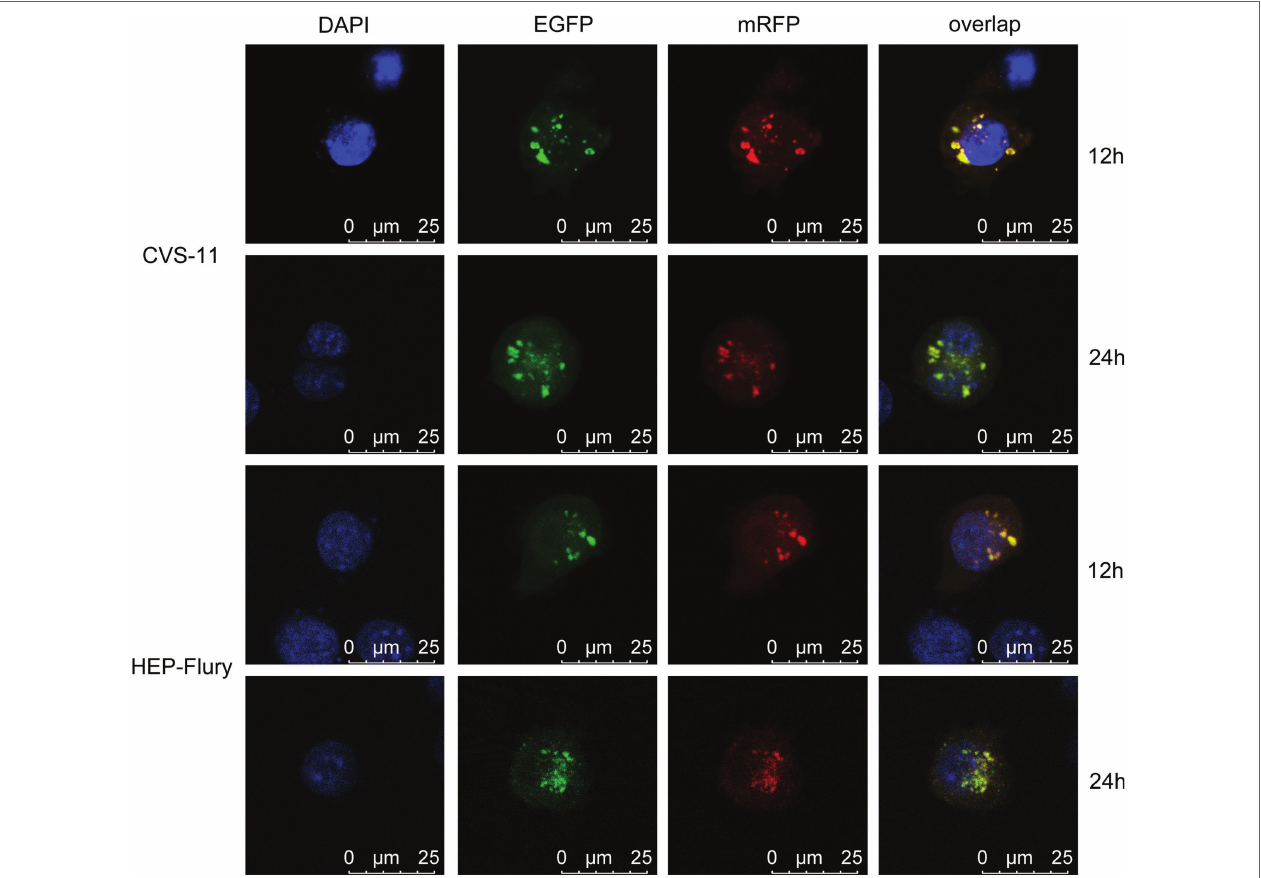
FIGURE 4 | To monitor the fusion of autophagosomes with lysosomes, BV2 cells were transfected with mRFP-EGFP-LC3 plasmids and then, respectively, infected with CVS-11 or HEP-Flury at an MOI of 3. The fluorescent dots in BV2 cells were analyzed directly at 12 and 24 hpi by confocal